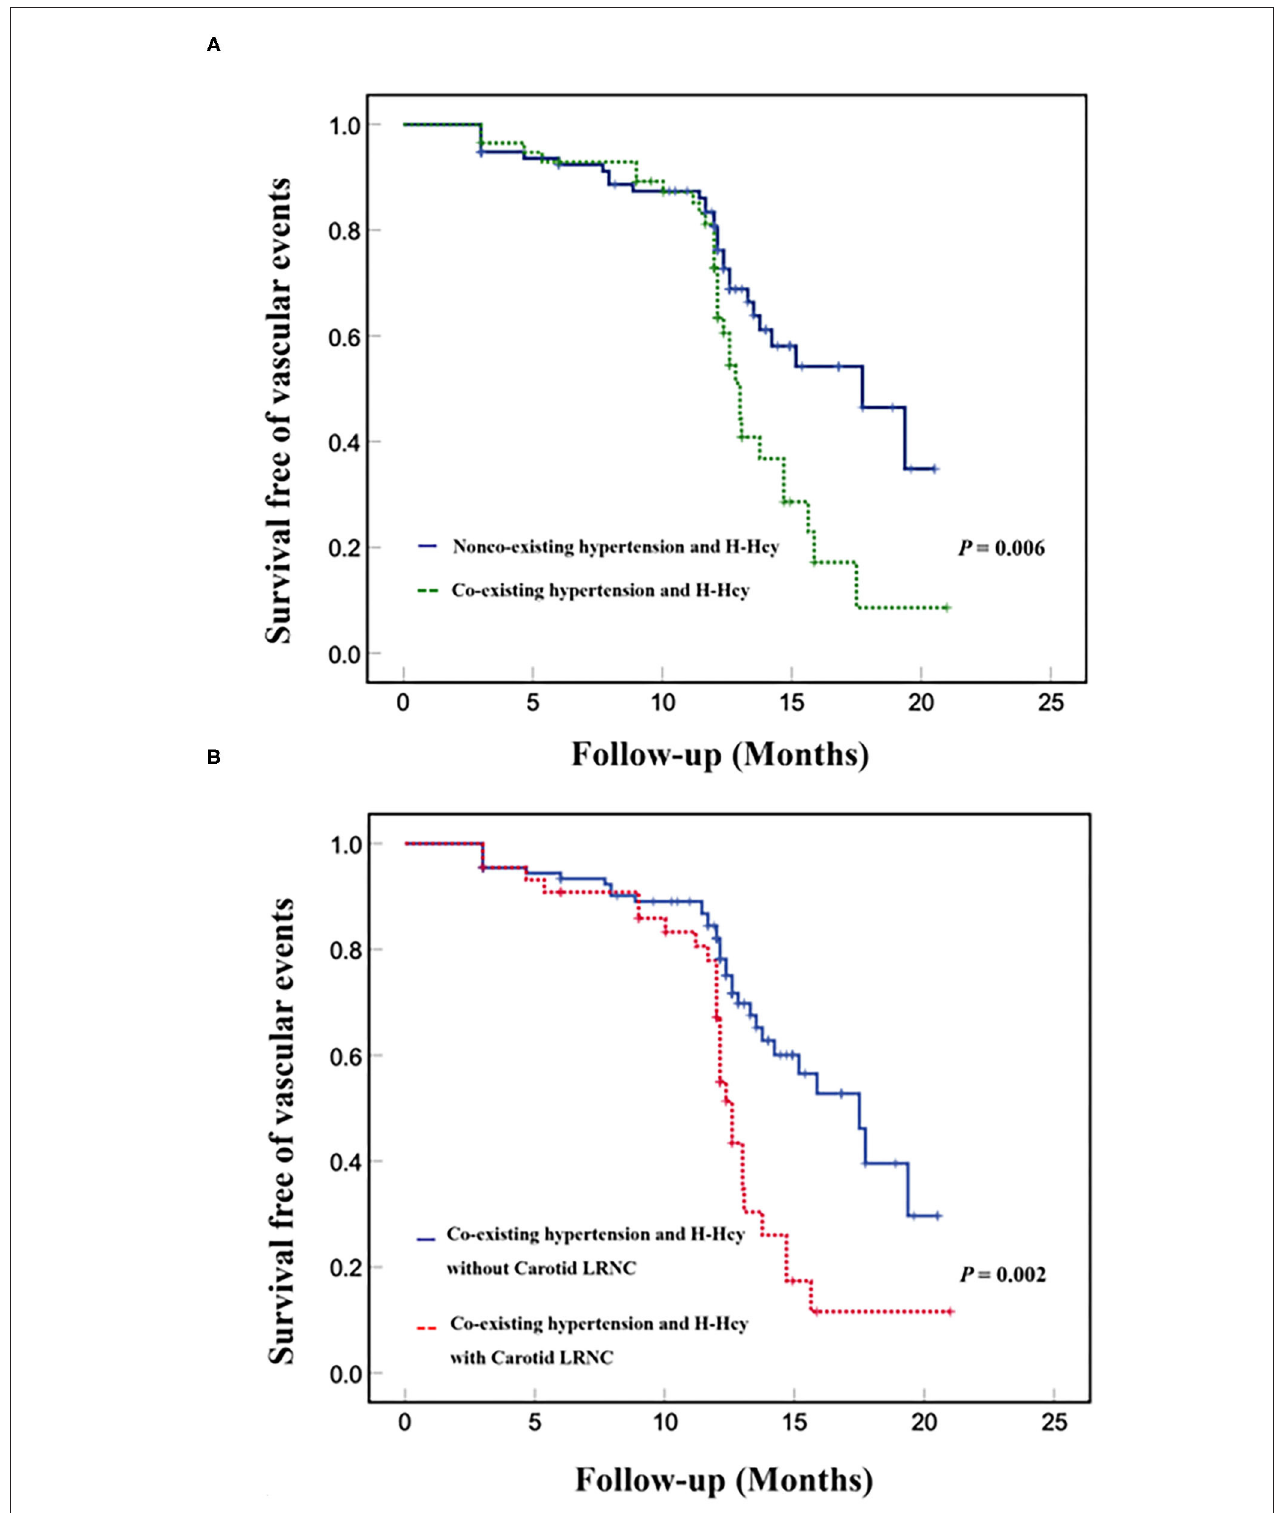
FIGURE 1 | Kaplan-Meier analysis of survival free of vascular events in co-existing hypertension and H-Hcy. Kaplan-Meier curves of event-free survival of subsequent vascular events in patients with and without co-existing hypertension and H-Hcy (A) . Kaplan-Meier curves of event-free survival of subsequent vascular events in patients with co-existing hypertension and H-Hcy alone and patients with a combination of coexisting hypertension and H-Hcy with carotid LRNC (B) . The X-axis represents the time of follow-up in months. The Y axis represents the proportion of patients who were survival free of vascular events.